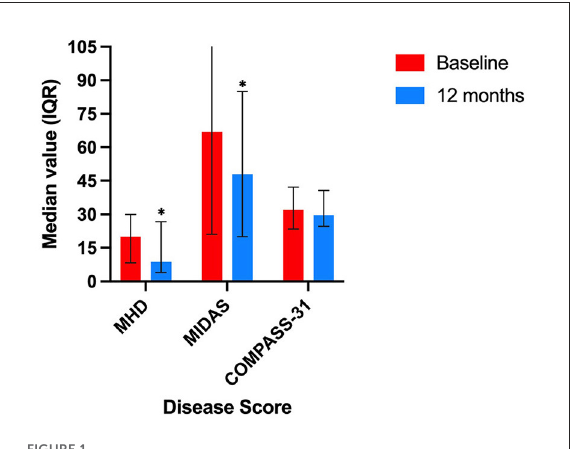
FIGURE1 Response of cohort by symptom score over 12 month follow-up period. MHD, median monthly headache days; MIDAS, median Migraine Disability Assessment Score; COMPASS-31, median Composite Autonomic Symptom Score, *denotes statistically significant